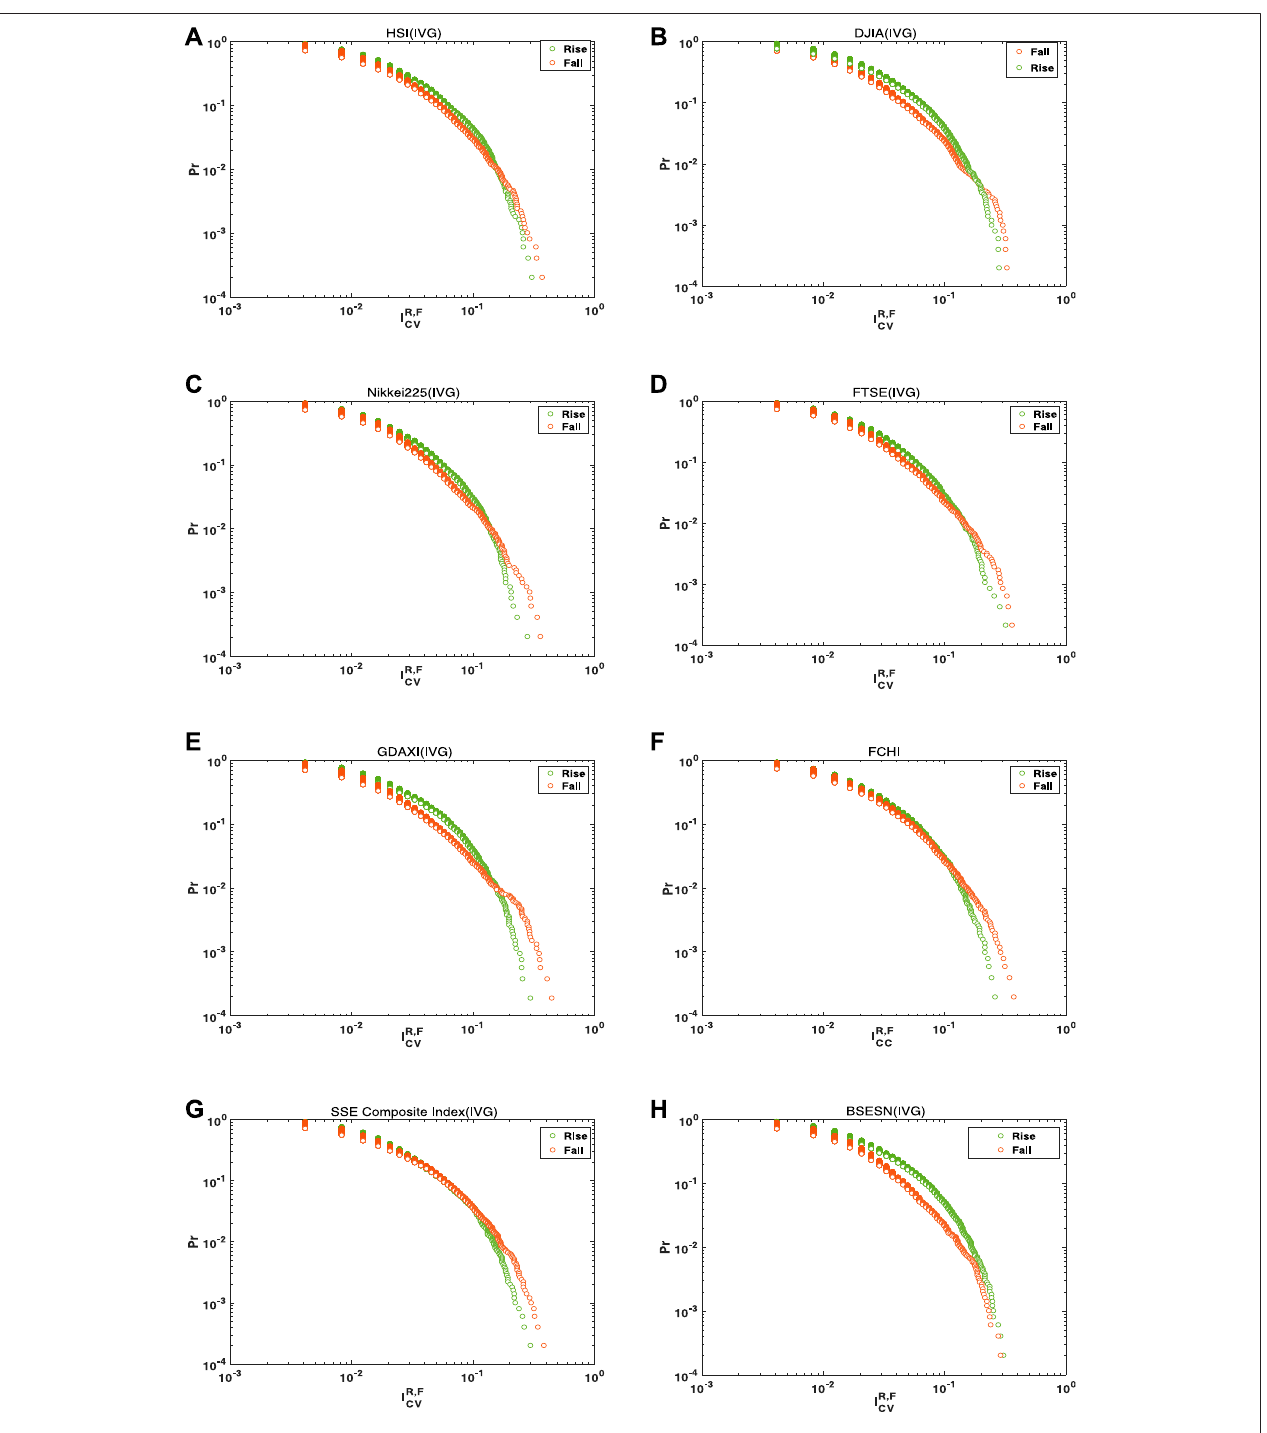
FIGURE 7 | Distributions of rise and fall I R , F CV values for the eight stock indices: (A) Hong Kong Hang Seng; (B) Dow Jones Industrial Average; and (C) Japanese Nikkei 225, London FTSE 100, German DAX, French CAC40, Shanghai SSE Composite, and Indian BSE.